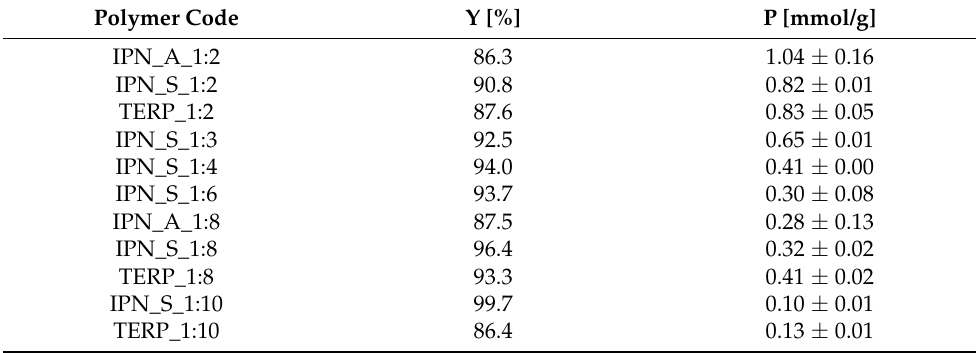
Table 2. The yield of synthesis and phosphorus